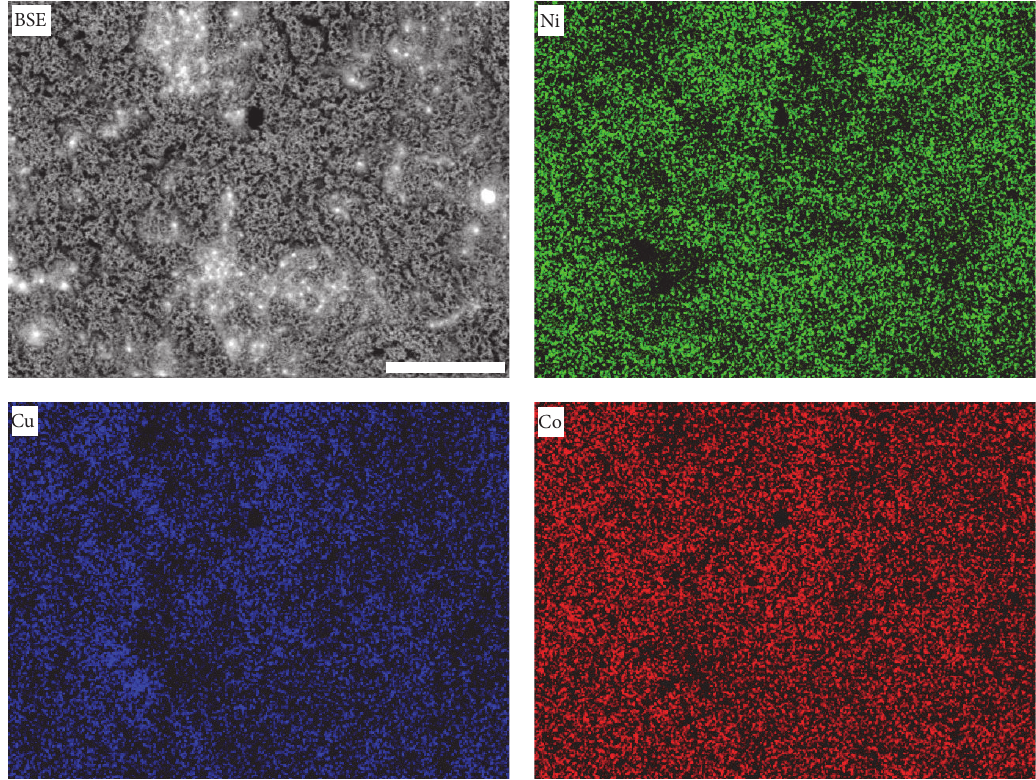
Figure 4: An example backscattered electron (BSE) image and EDS map of a sample from Set D. The sale bar is 200 𝜇 m for all the